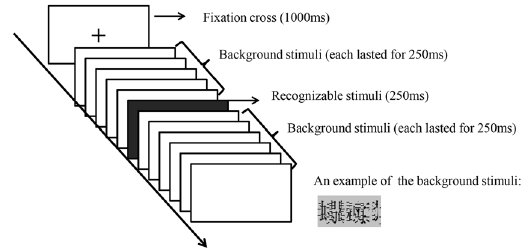
Figure 5. An illustration of the RSS procedure for the stimulus